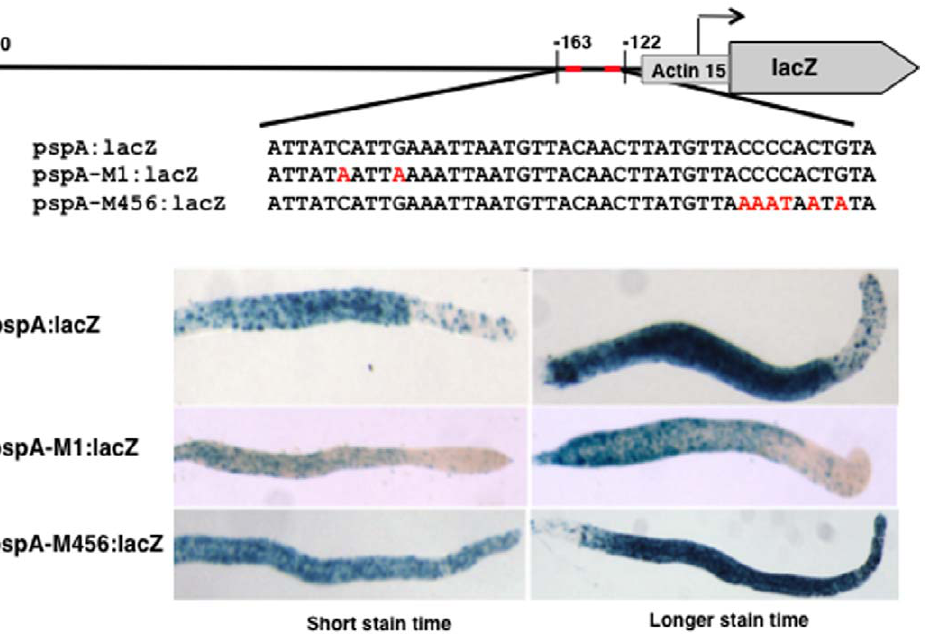
Figure 3. Expression patterns of pspA reporter fusions. The pspA promoter region 2 990 to 2 122 (pspA:lacZ), and versions of the same region containing a mutation of either the W (pspA-M1:lacZ) or S (pspA-M456:lacZ) sites. Expression patterns were established in standing slugs stained with X-gal.